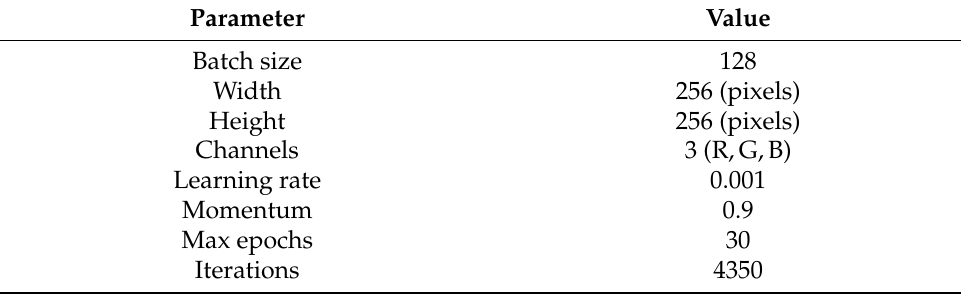
Table 3. Parameter Values Used in YOLO-based